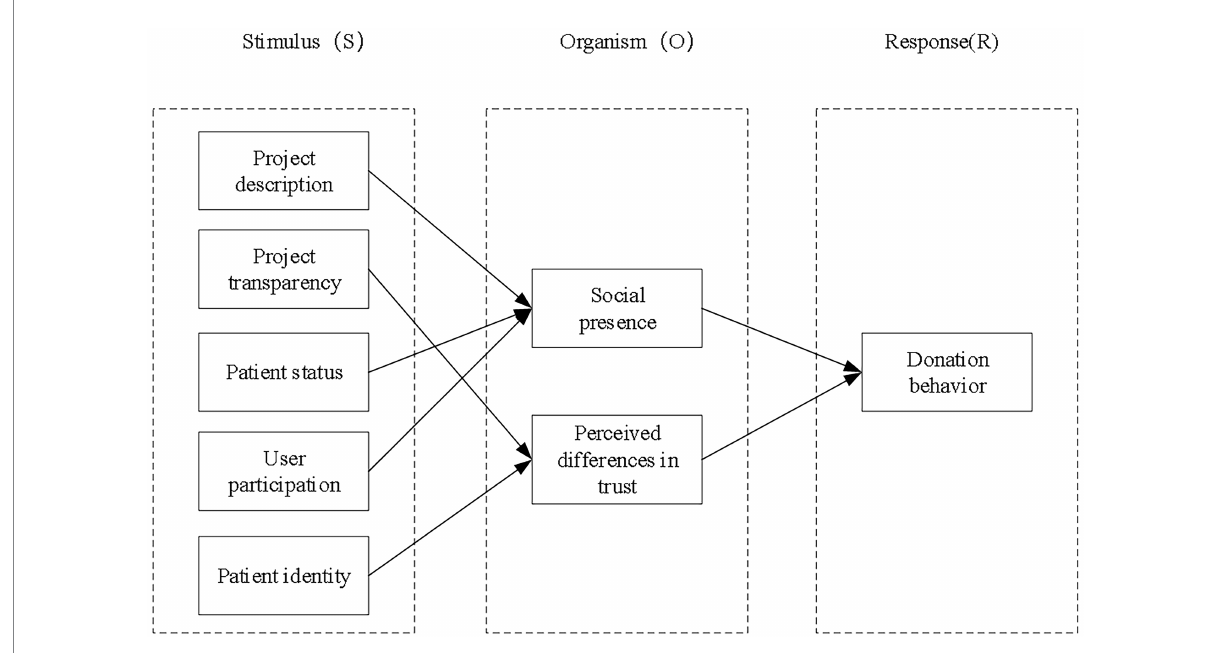
FIGURE 1 Research model of donation behavior for medical crowdfunding